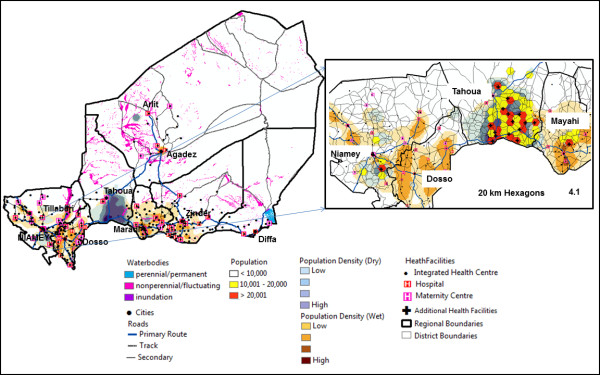
Proposed placement of new health facilities in population densities with the least access to a health facility. The maps show the most likely placement of proposed new health facilities within the densely populated regions using two different widths of hexagon. Proposed new health facilities were placed in the red hexagons (4.1).